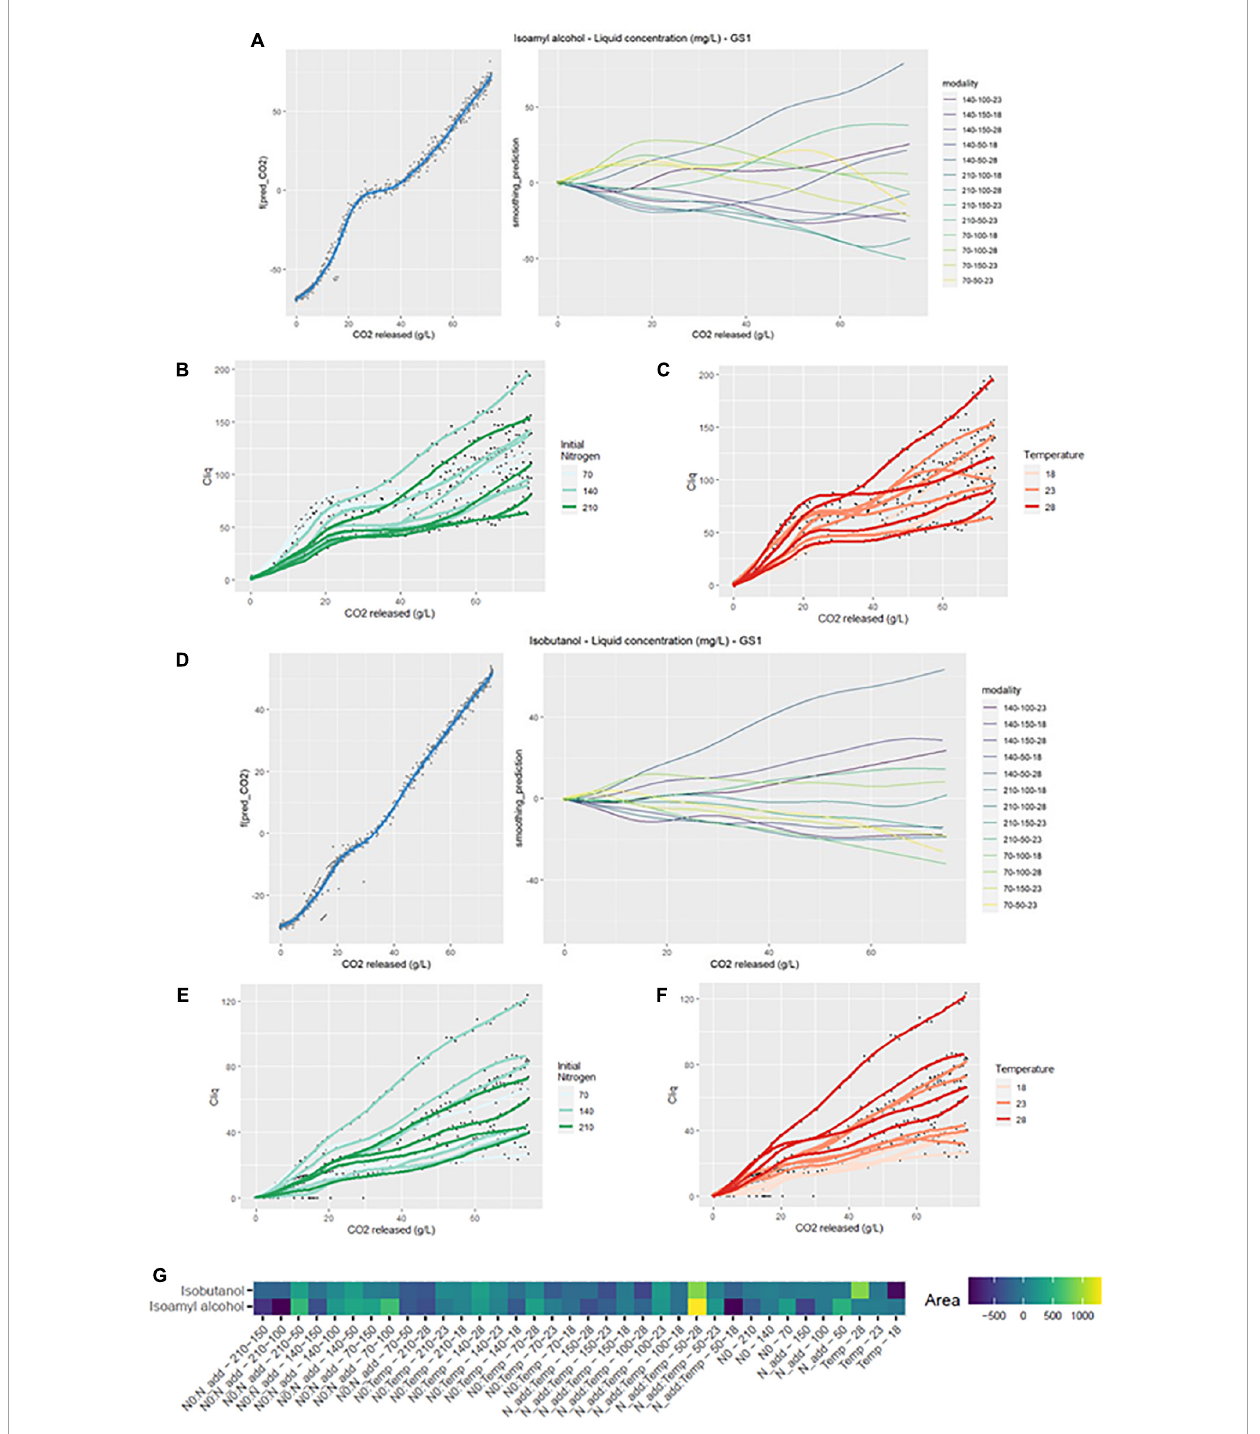
FIGURE2 GAM modeling of ISOH and ISB production kinetics. (A,D) Left: Smoothing average of ISOH and ISB concentration, right: Deviations of each modality from this average smoothing. (B,C,E,F) Prediction curves for each modality represented with a color depending on the level of NO and temperature. (G) Heatmap representing magnitudes of each factor and every possible interaction using areas under the curves of the deviations from the average smoothing, for ISOH and ISB.